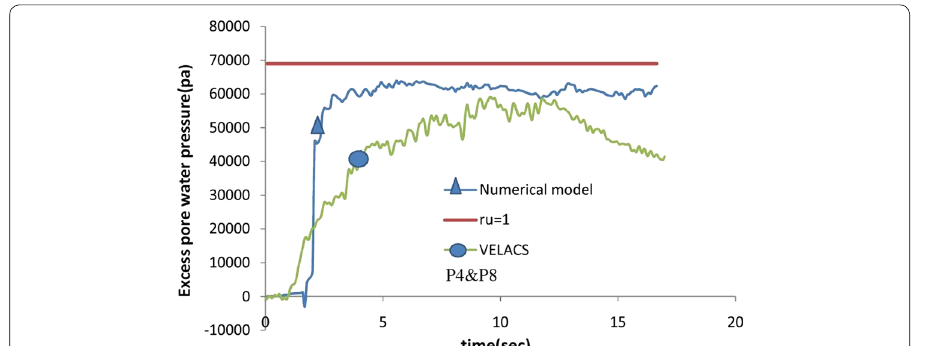
Fig. 7 Comparison of excess pore water pressure values at depth of 7.5